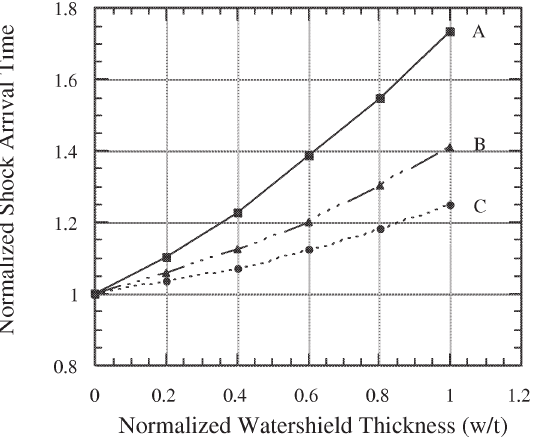
Fig. 7. Normalized shock arrival time of contact